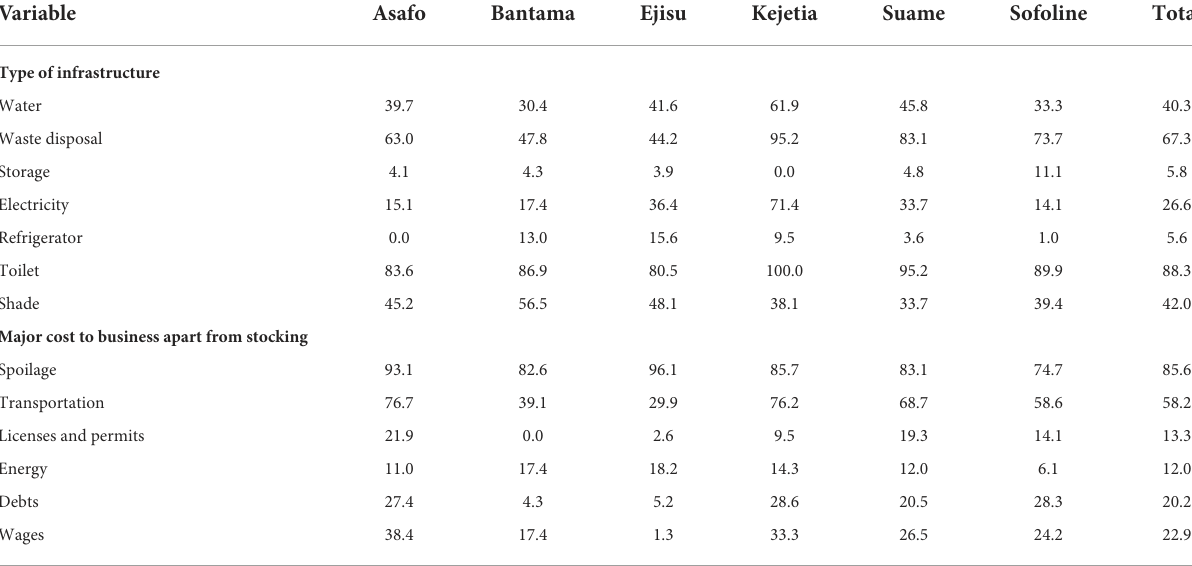
TABLE 4 Type of infrastructure available to traders at the market and major cost associated with their trading in Kumasi.